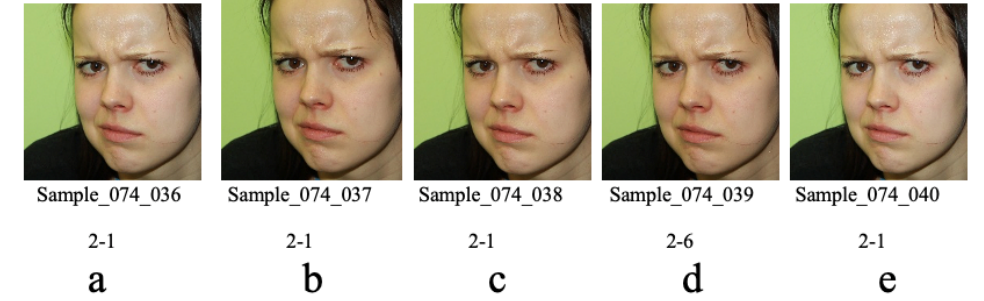
Figure 7. Continuous images for one